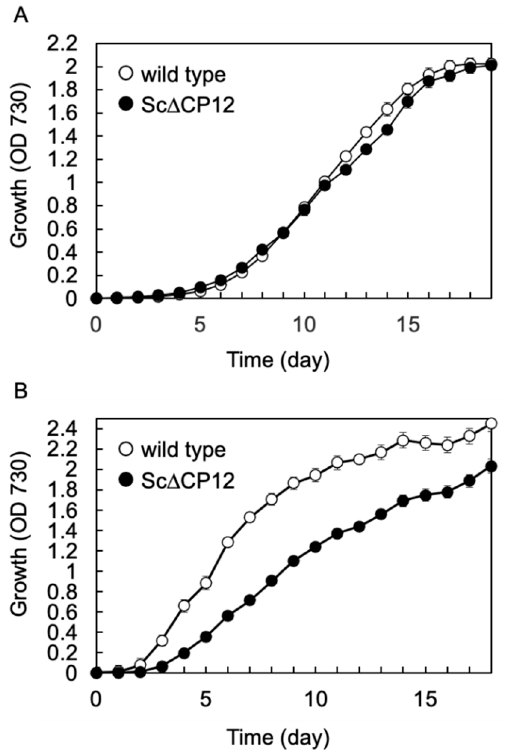
Figure 1. The time-course of photoautotrophic growth of wild-type and Sc ∆ CP12 mutant S. 7942 cells under continuous light conditions. Wild-type and Sc ∆ CP12 mutant S. 7942 cells were cultured in 1 L of Allen’s medium at 27 °C under continuous illumination ( A ): 40 μ mol s − 1 m − 2 , ( B ): 100 μ mol s − 1 m − 2 ) with bubbling of sterile air at 1 L min − 1 .